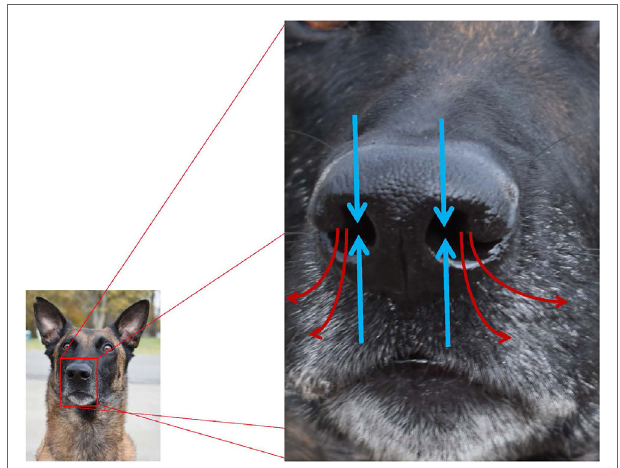
FigURe 3 | Pathways for inhalation and exhalation and airflow associated with olfaction (blue arrows = inhaled; red arrows = exhaled). Canines preferentially use the right nostril to sniff conspecific arousal odors and novel odors, and the left nostril to sniff familiar odors, non-aversive stimuli, and heterospecific arousal